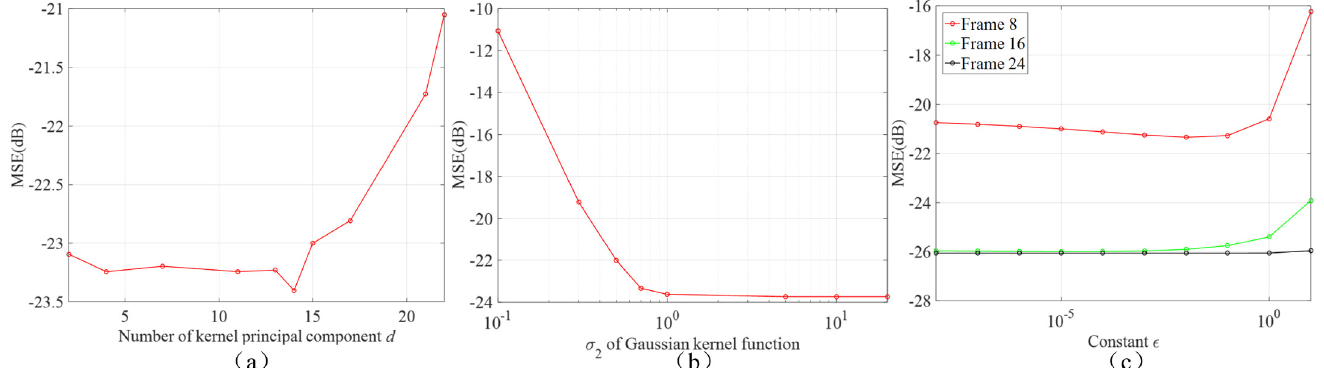
Fig 10. The influence of parameters in KGF (a) number of kernel principal component d and (b) σ 2 of Gaussian kernel function and (c) constant � on sinograms MSE.